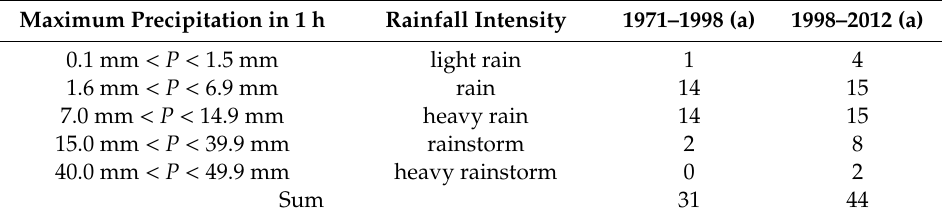
Table 4. Precipitation intensity in di ff erent